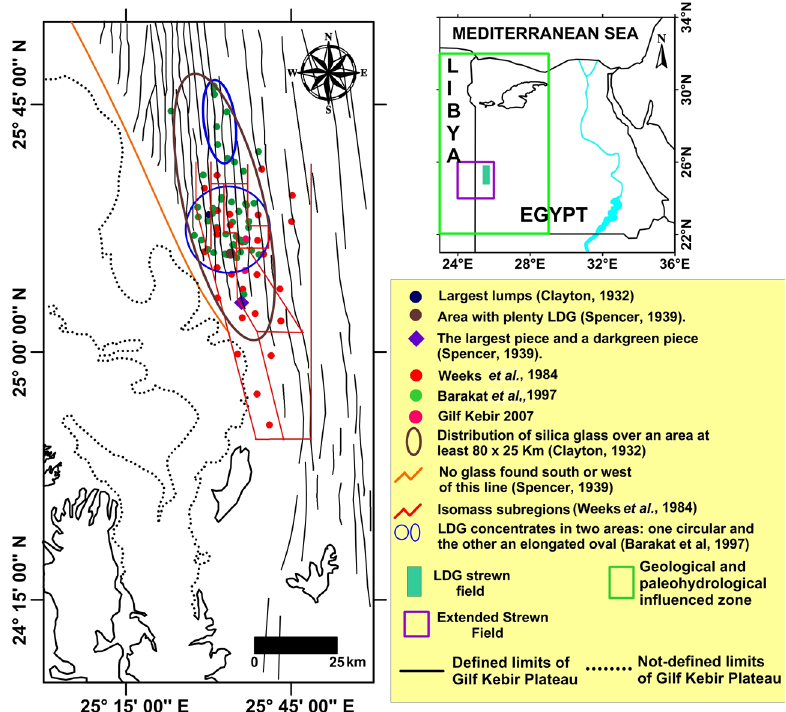
Figure 1. The study area and the different reported Libyan Desert Glass (LDG)-strewn fields. Brown ellipse: the smallest distribution zone [6]; red line: the largest distribution zone [9]; orange line: the common western limit of LDG deposition [8].